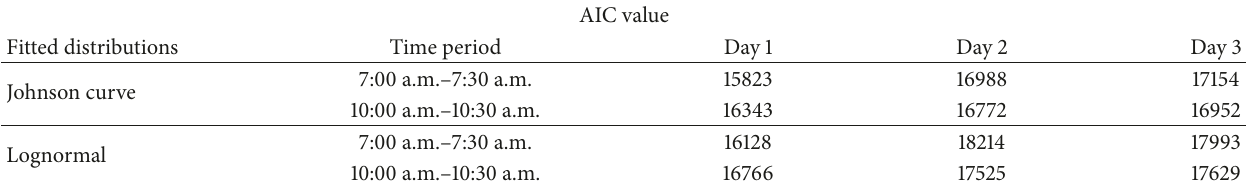
Table 2: AIC values for the Lognormal model and the Johnson-curve